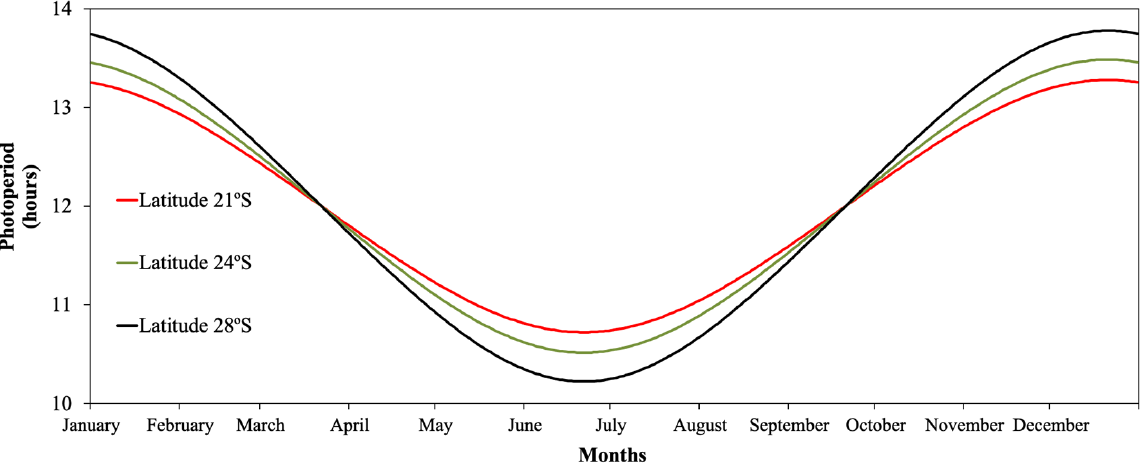
Figure 7. Day length in hours (photoperiod) throughout the year in three locations in Brazil: Lages, Santa Catarina state (latitude 28° S), Palotina, Parana state (24° S), and Ribeirao Preto, Sao Paulo state (21° S).